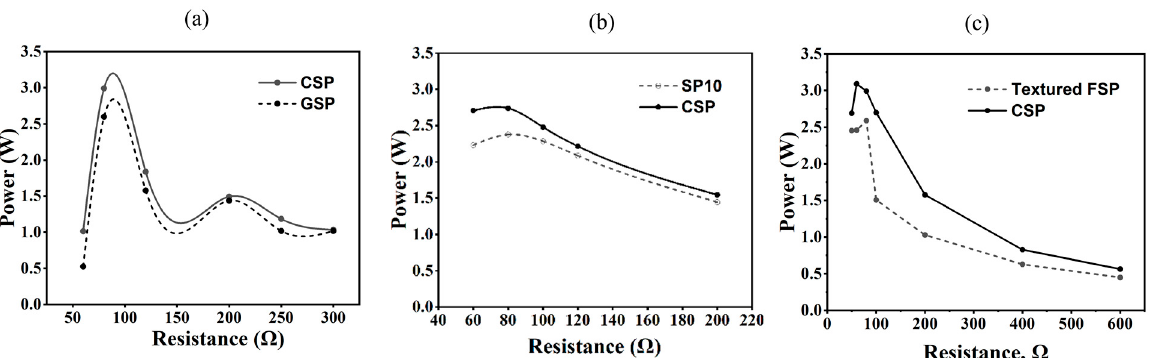
Figure 8. Power production for the solar modules at different resistance values versus the CSP for ( a ) GSP, ( b ) SP10, and ( c ) textured float glass panel.